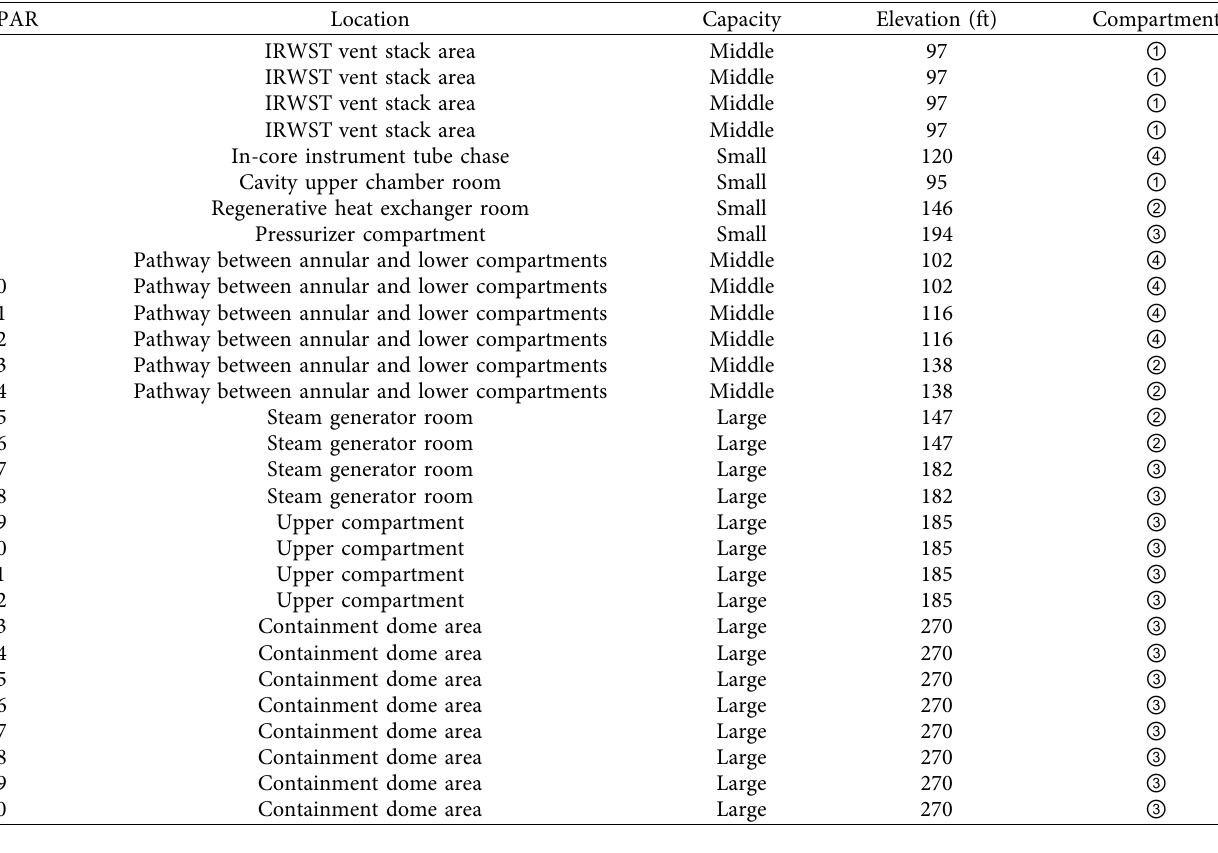
Table 4: PAR distribution